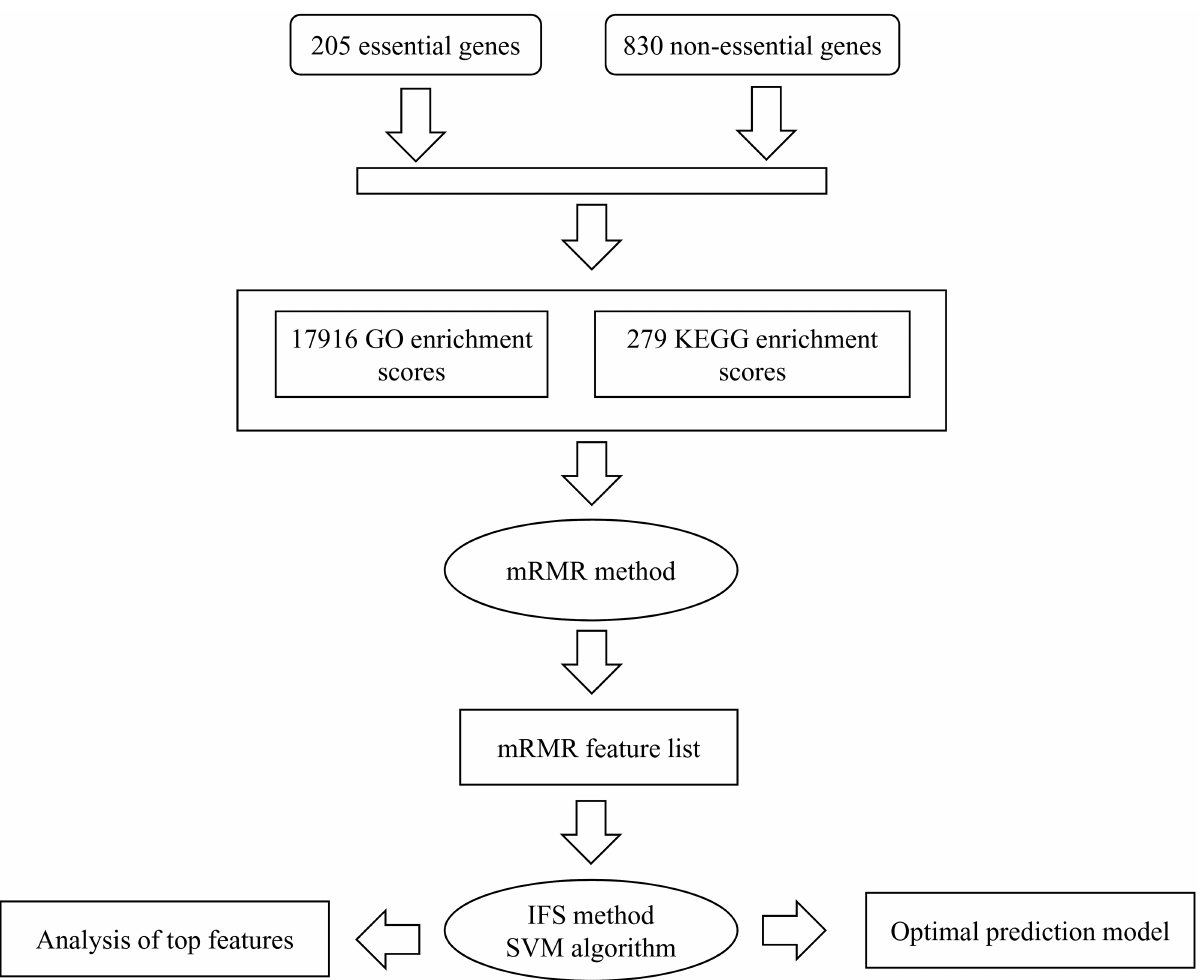
Fig 1. Flow chart of the whole procedure for investigating essential and non-essential